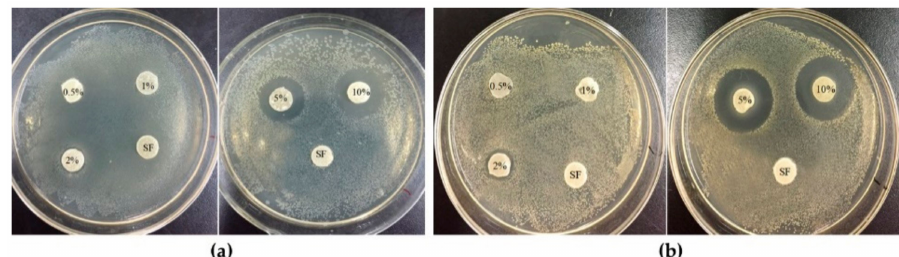
Figure 6. Bacterial growth inhibition by the disk method. Porous PHMB / SF sponges were incubated at 37 ◦ C for 24 h on agar plates cultured with ( a ) E. coli and ( b ) S. aureus . 0.5%, 1%, 2%, 5%, and 10% represent the sponges with PHMB / SF ratios of 0.5 / 100, 1 / 100, 2 / 100, 5 / 100, and 10 / 100, respectively. SF represents PHMB free